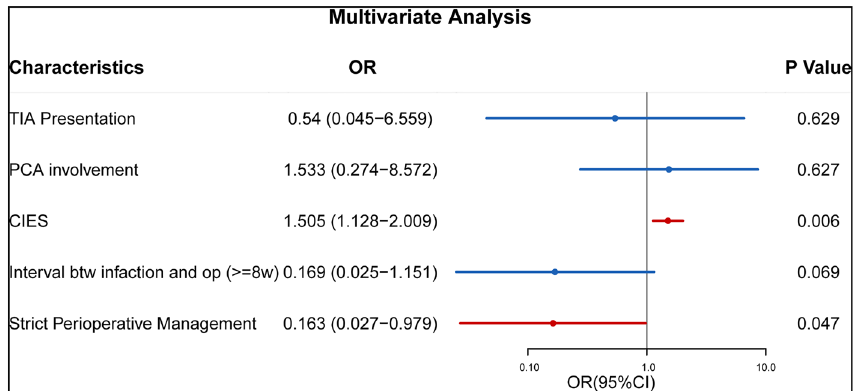
Figure 4. Multivariate analysis of postoperative ischemic complications. CIES cerebral infarction extent scoring system, TIA transient ischemic attack, PCA posterior cerebral